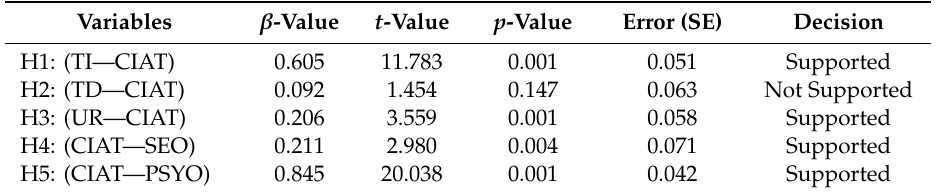
Table 5. Path analysis parameter estimates, their standard errors, and their